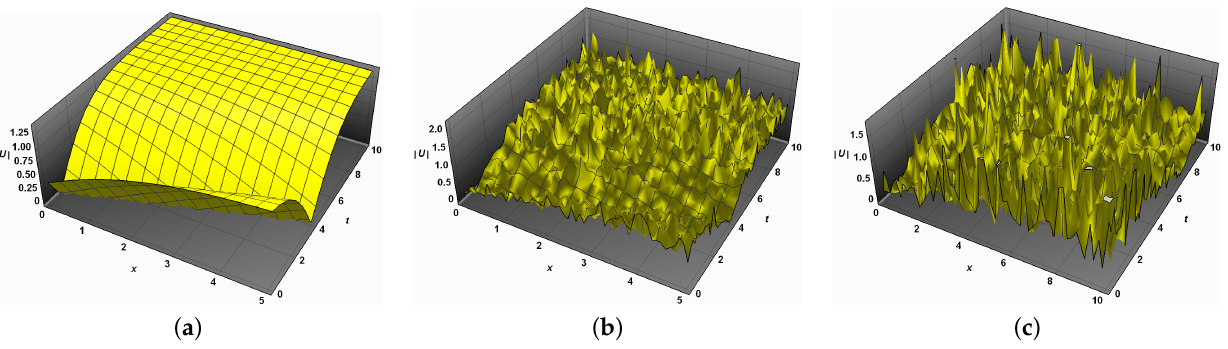
Figure 4. Two-dimensional representation of the solution (24) for distinct values of the noise σ , α = 1, x = 1, y = 0.5, and t ∈ [ 0,10 ] .